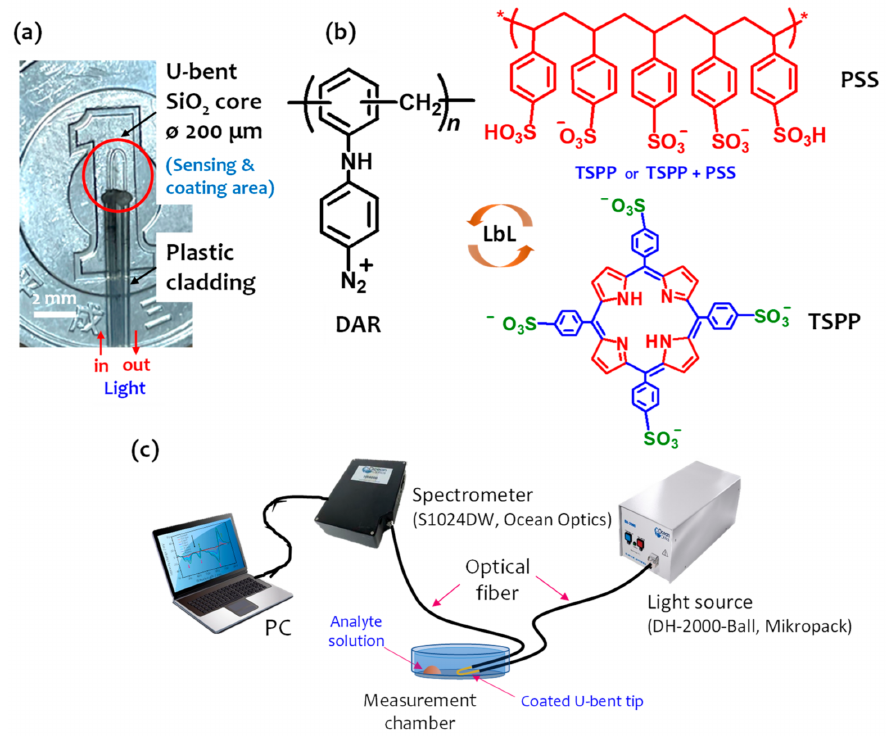
Figure 1. ( a ) Photograph of a U-bent optical fiber. ( b ) Chemical structures of DAR, TSPP, and PSS and a schematic of the LbL assembly of DAR and TSPP, or DAR and a TSPP+PSS binary mixture on a multimode U-bent optical fiber core followed by exposure to UV-radiation at 365 nm. ( c ) Schematic of the experimental setup for gas